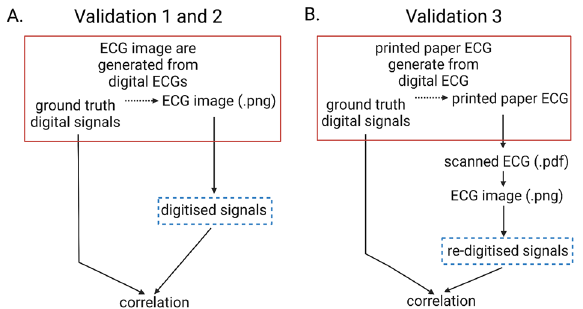
Figure 4. Validation of ECG digitisation tool. Text in red boxes represents input data. Digitised signals generated by our digitisation tool are indicated in blue dashed boxes ( A ) Validation 1 and 2: comparison of digitised ECG traces with ground truth digital signals; ( B ) Validation 3: comparison of digitised ECG traces from digital ECGs that were printed, scanned and re-digitised, with ground truth digital